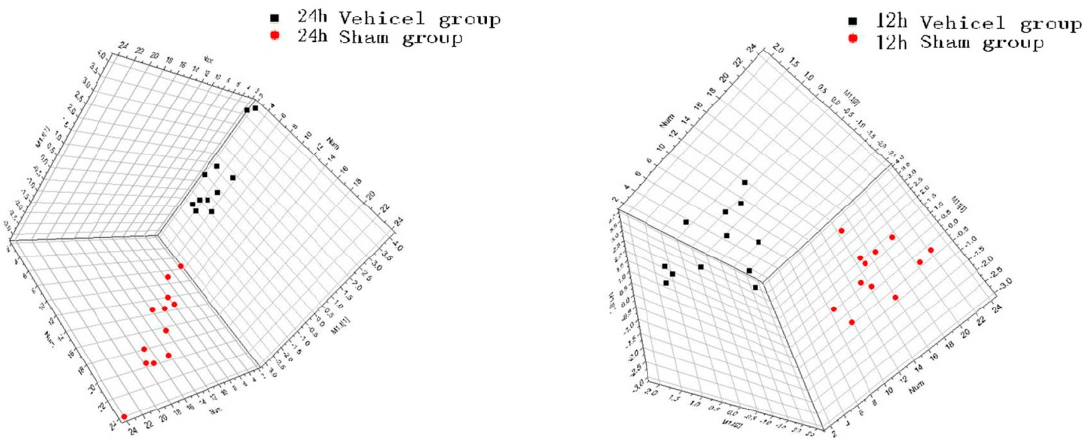
Figure 3. PLS-DA score plots derived from sham group and vehicle group of 12 h and 24 h MCAO by SIMCA-P12.0. In the score plots, the spots of the vehicle groups were clearly separated from the sham groups.